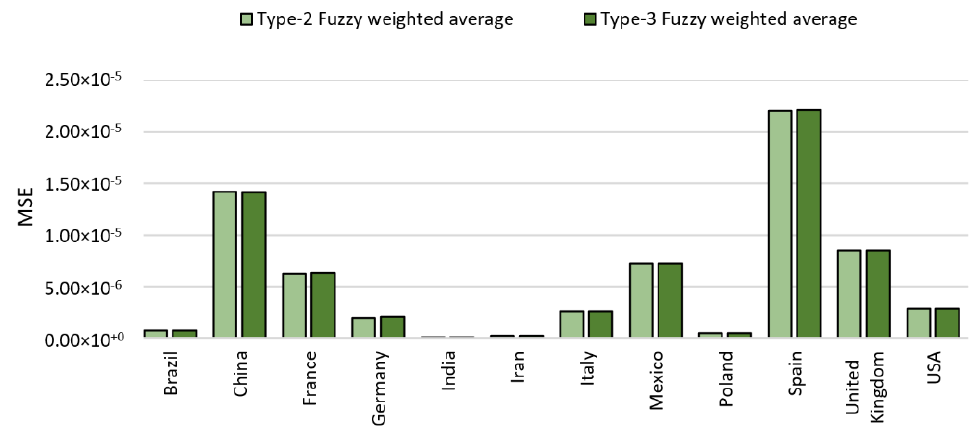
Figure 26. First data period (testing prediction).